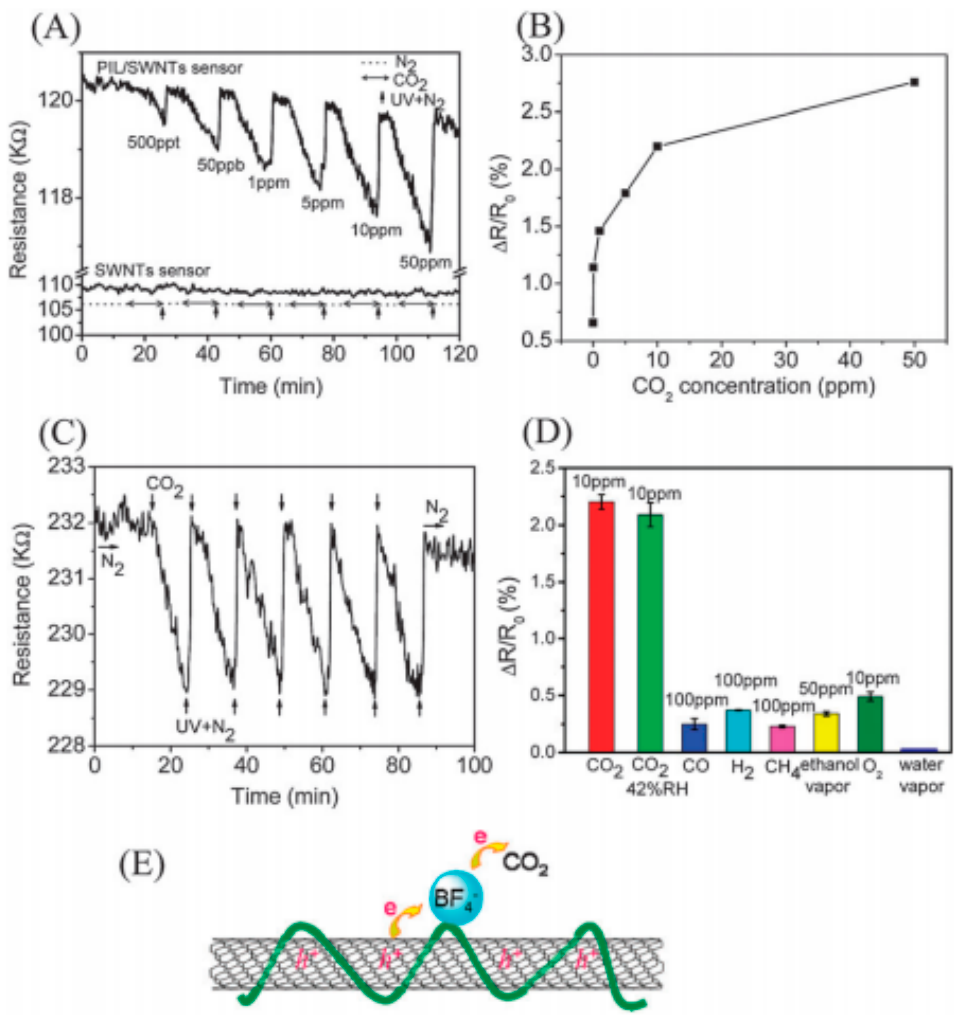
Figure 18. ( A ) shows the response of pristine single walled carbon nanotubes ( B ) Change in resistance with respect to CO 2 concentrations. ( C ) Successive injections of 1 ppm CO 2 to the sensor. ( D ) Response of the sensor to: CO 2 (10 ppm); CO 2 (10 ppm) + relative humidity (42%); 100 ppm H 2 ; 100 ppm CH 4 ; 50 ppm ethanol; 10 ppm O 2 and relative humidity (42%). ( E ) Sensor mechanism. Reproduced with permission from [67].